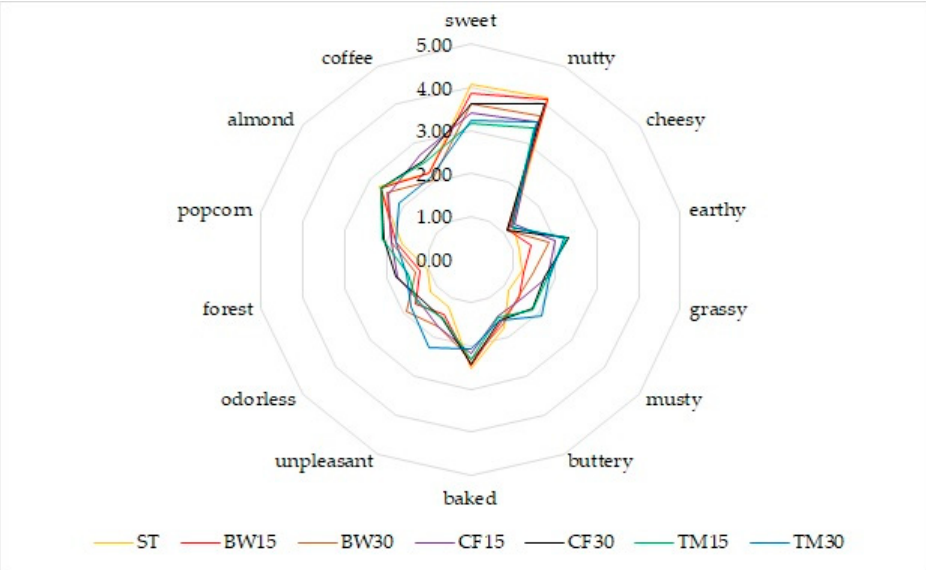
Figure 1. Organoleptic characteristics of bars—smell profile.